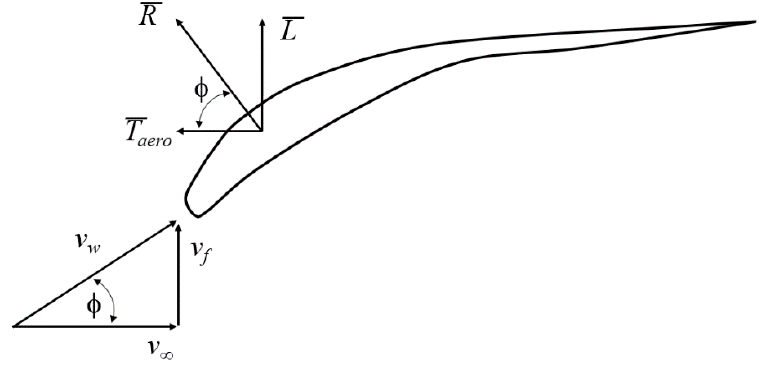
Figure 1. The vector field at a given wing station “ y ” and at an instant t during the downstroke.